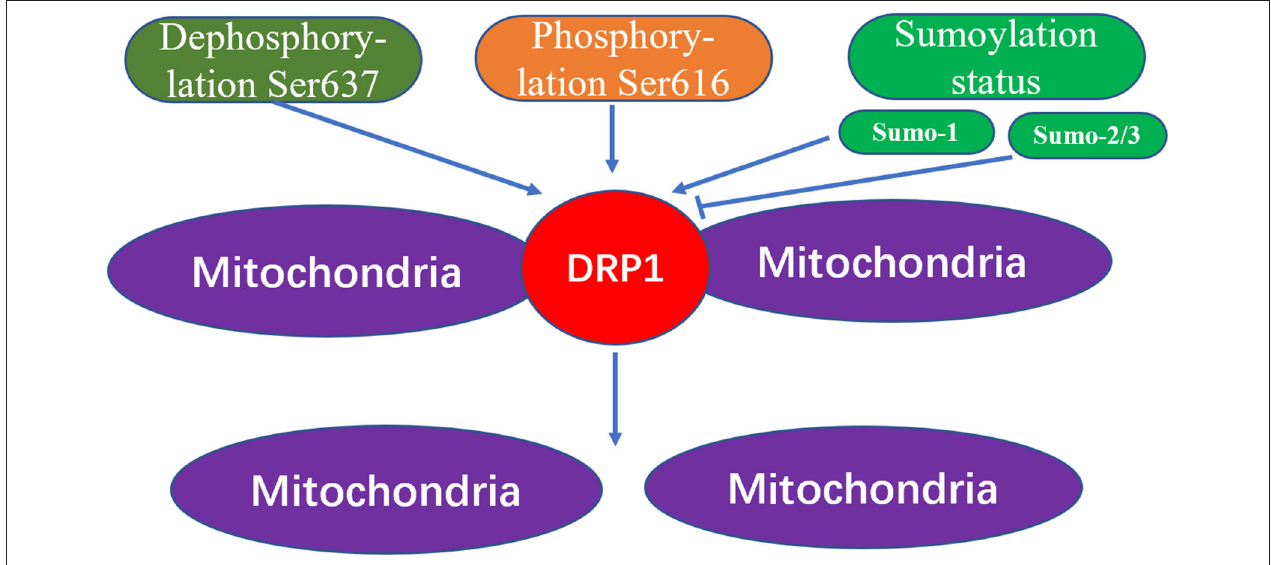
FIGURE 3 | The mechanism of mitochondrial fission caused by Drp1 modification. The increased dephosphorylation of Ser637 on the drp1 protein or the increased phosphorylation of Ser616, and the change of the sumoylation state of DRP1 will effect the activity of DRP1, thereby increasing the fission of